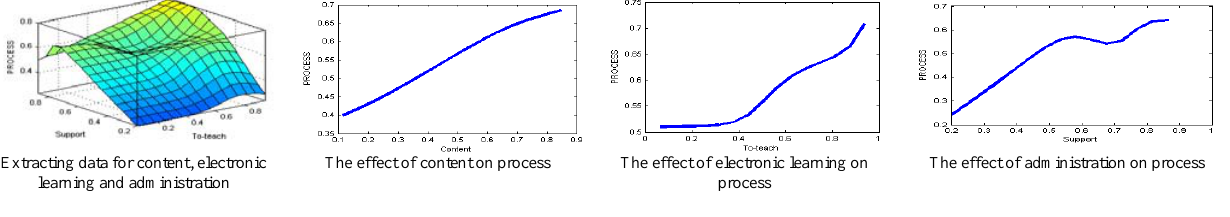
Fig. 4. The results of different factors on